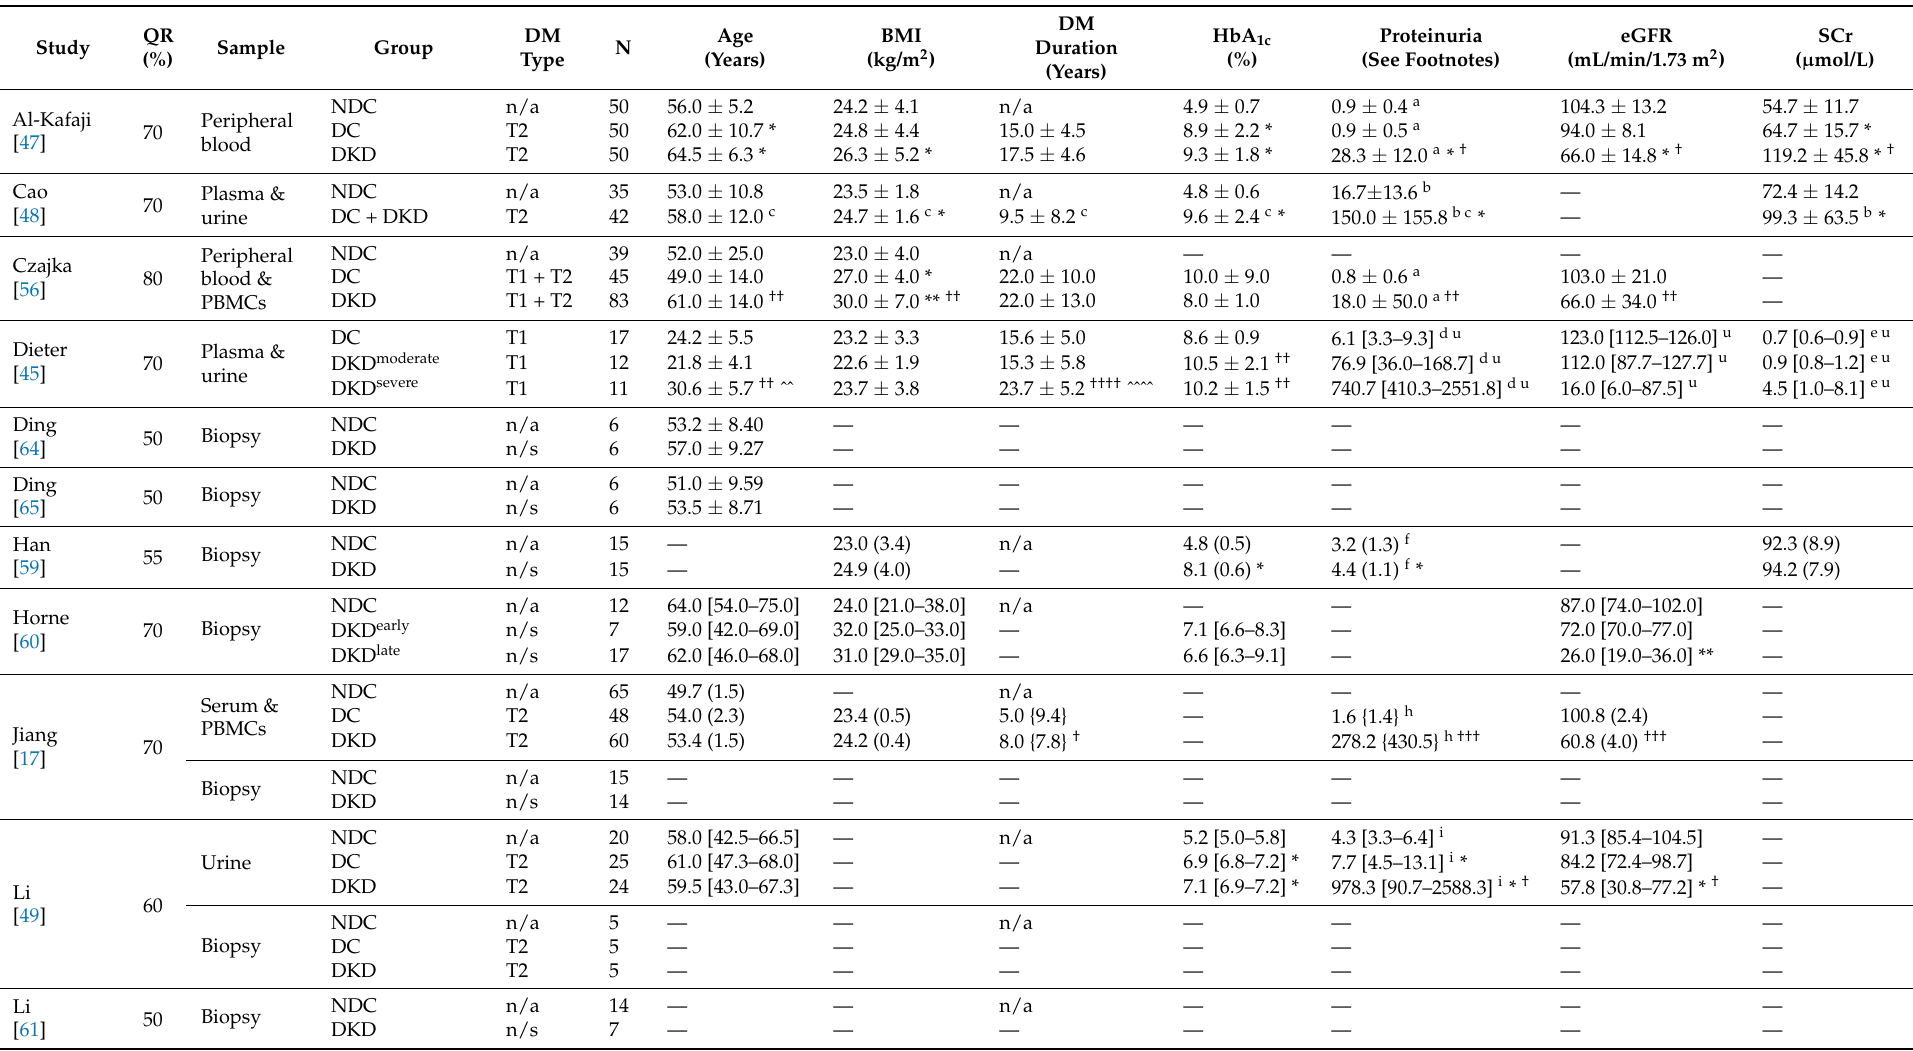
Table 1. Summary of population